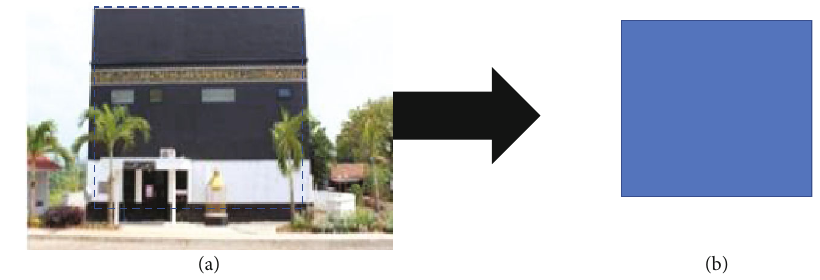
Figure 39: Construction building number ̂ 1